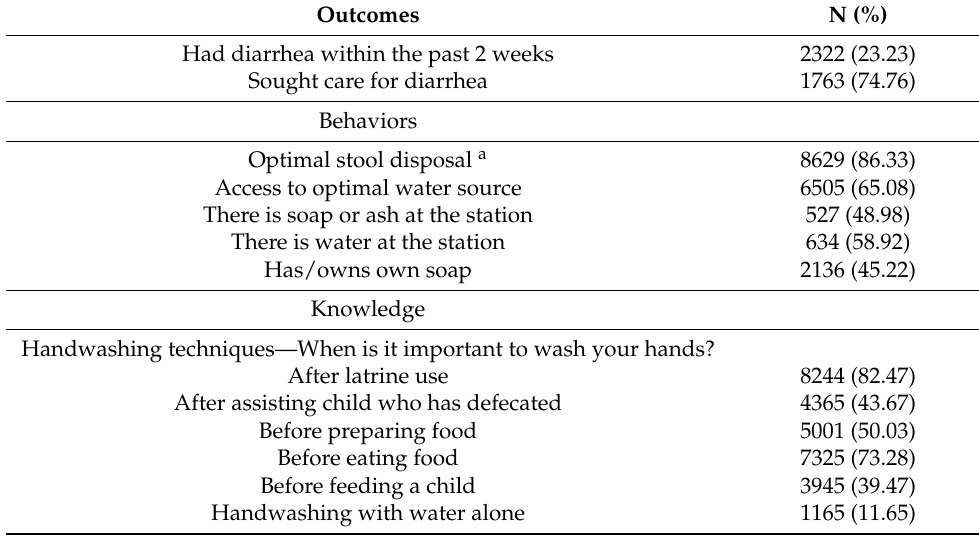
Table 3. Regression analysis for parental WASH behavior and knowledge and the association with child diarrhea during past 2 weeks (N =